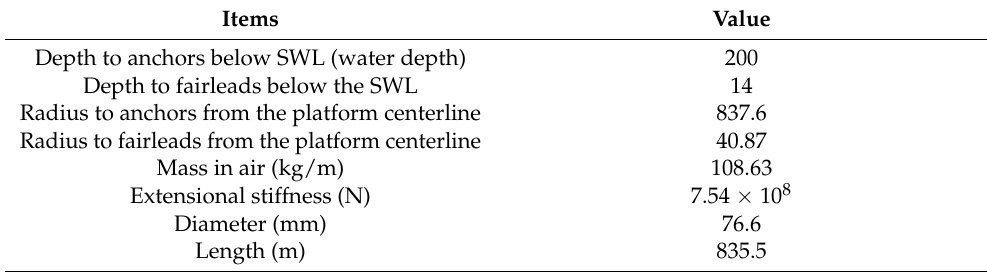
Table 3. Parameters of mooring